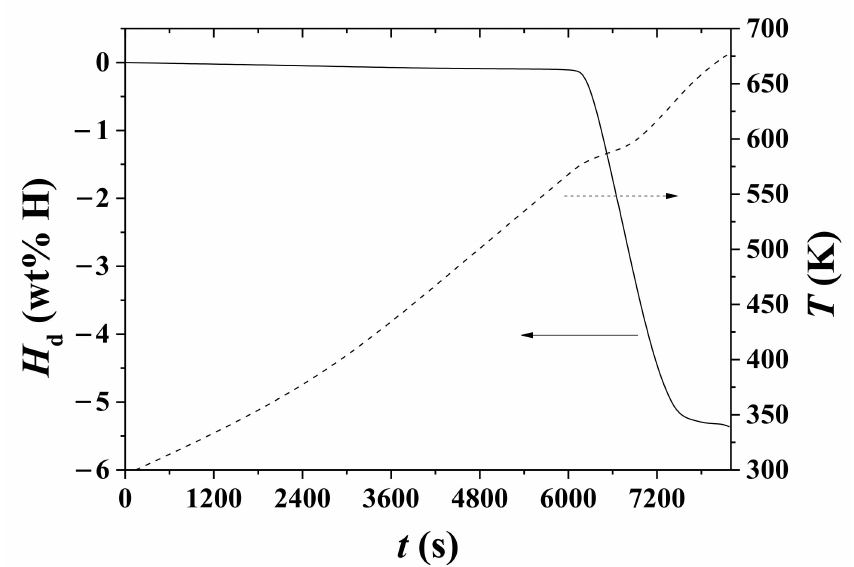
Figure 5. Variations in H d and temperature T with t under 1.0 bar H 2 for hydrided Mg–5Ni. The sample was heated with a heating rate of 3 K/min.